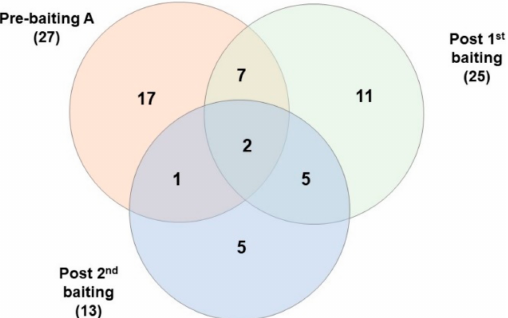
Figure 6. Venn diagram of the number of colonies at transect A before and after baiting in 2020 at